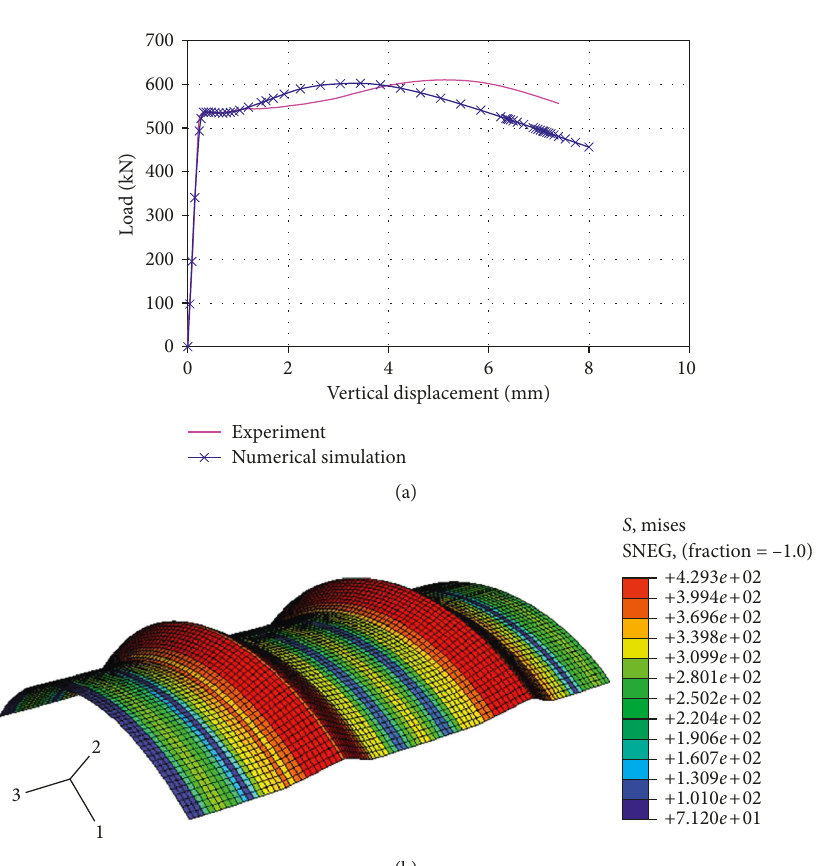
Figure 14: Unstrengthened shell—Series (I) comparison of experiment/simulation behavior and numerical buckling